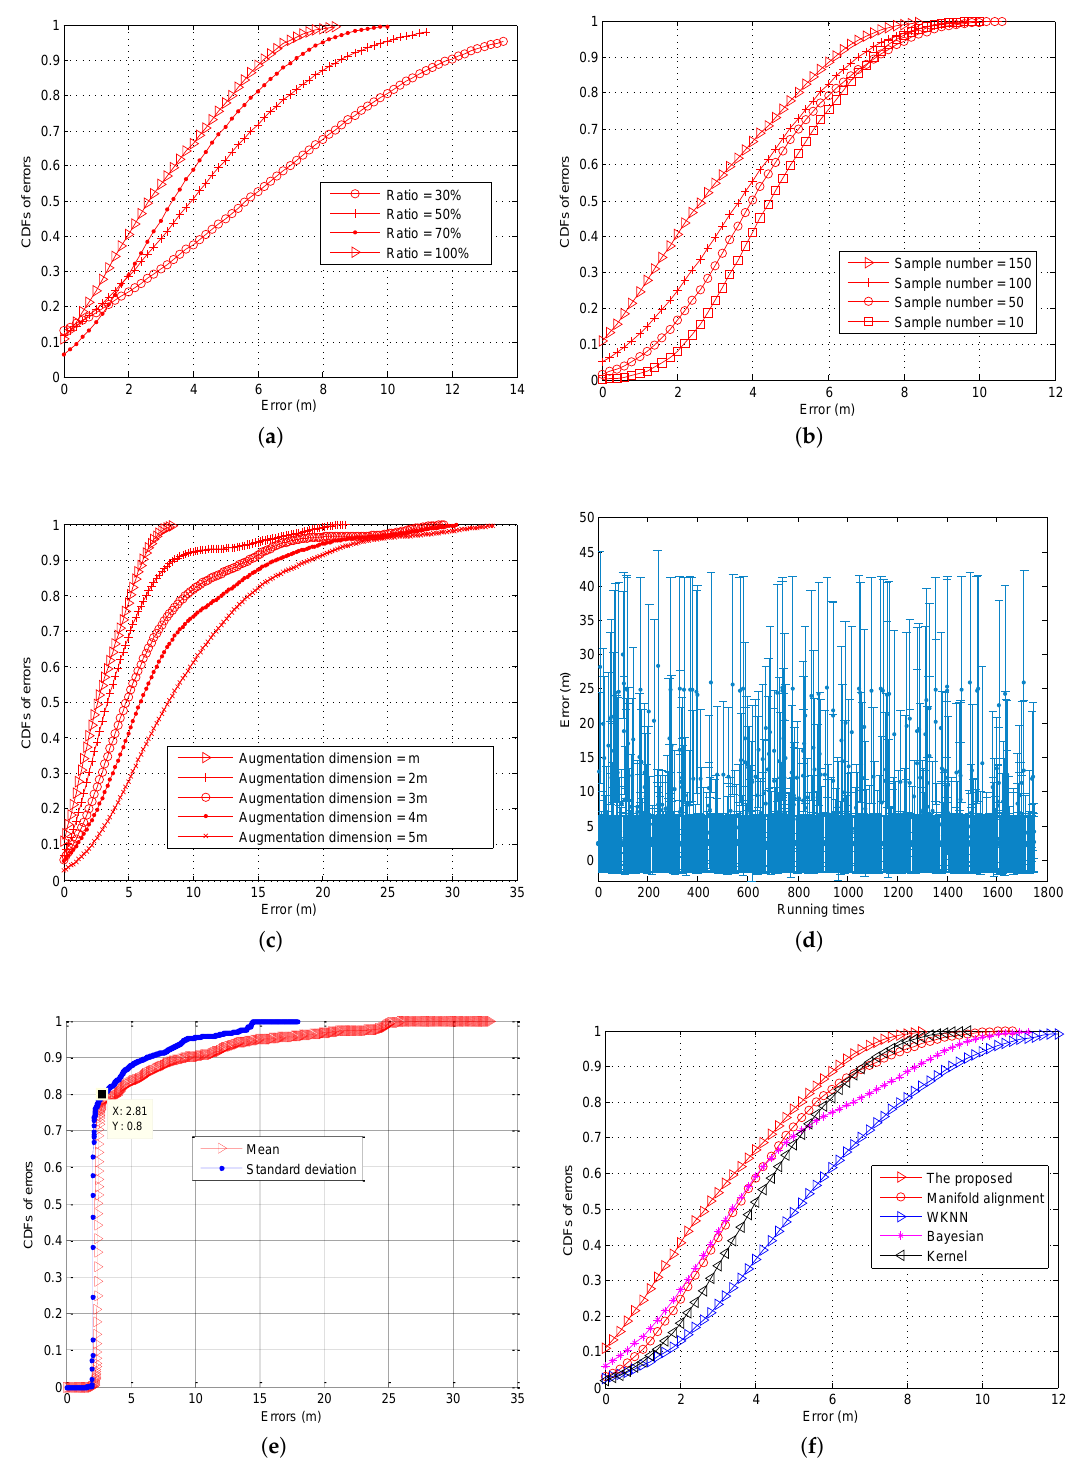
Figure 4. Parameter discussion in the actual environment. ( a ) CDFs of errors under different numbers of calibrated locations; ( b ) CDFs of errors under different numbers of RSS measurements; ( c ) CDFs of errors under different augmentation dimensions; ( d ) localization errors under different replications for physical coordinates augmentation; ( e ) CDFs of mean and standard deviation of errors; ( f ) CDFs of errors by different